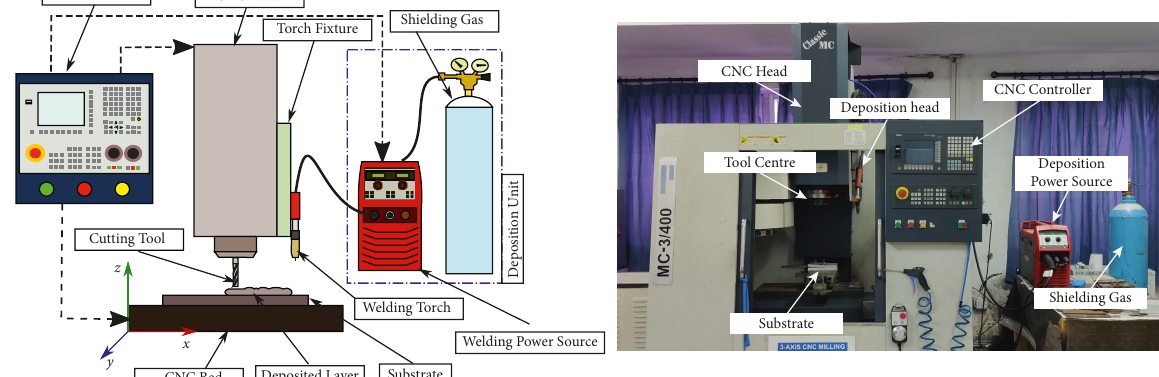
Figure 13: Schematic diagram and experimental setup of CNC-based H-WAAM process.